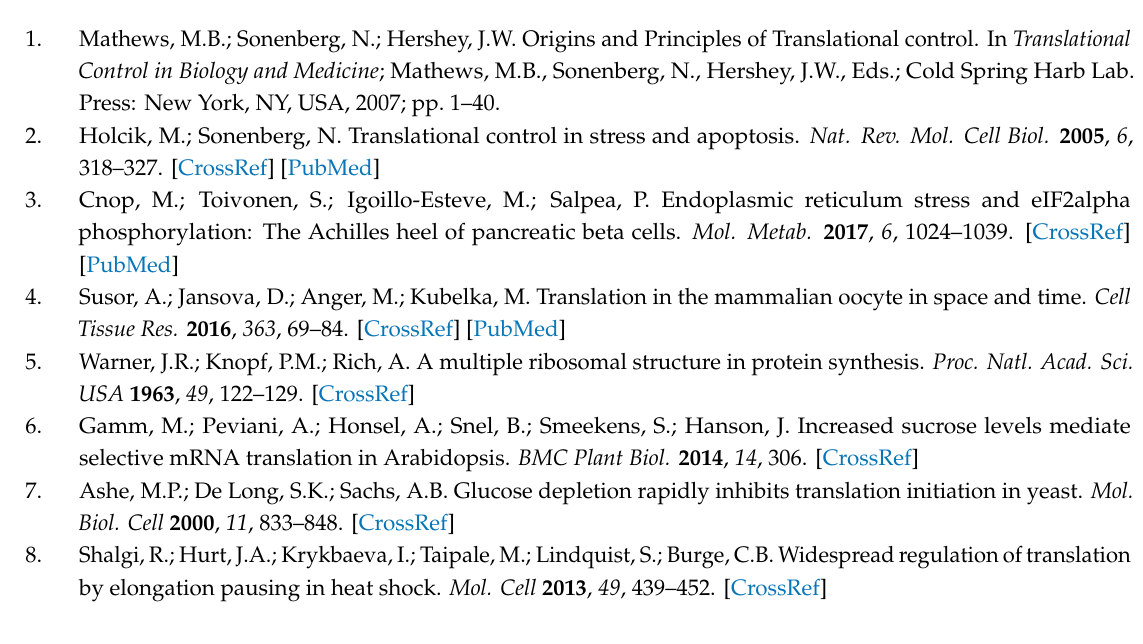
Table S2. Sheet S2-1: GSEA according to FPKM in P dataset, Sheet S2-2: GSEA according to P / NP ratio; Table S3. DeSeq2 analysis of polysome-bound mRNAs versus non-polysomal mRNAs; Table S4. List of used